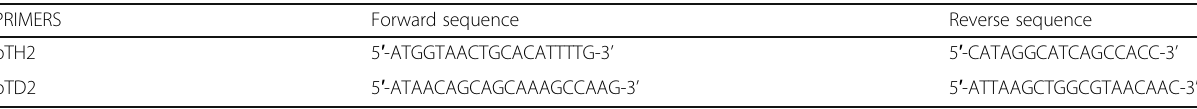
Table 2 Primers used for PCR